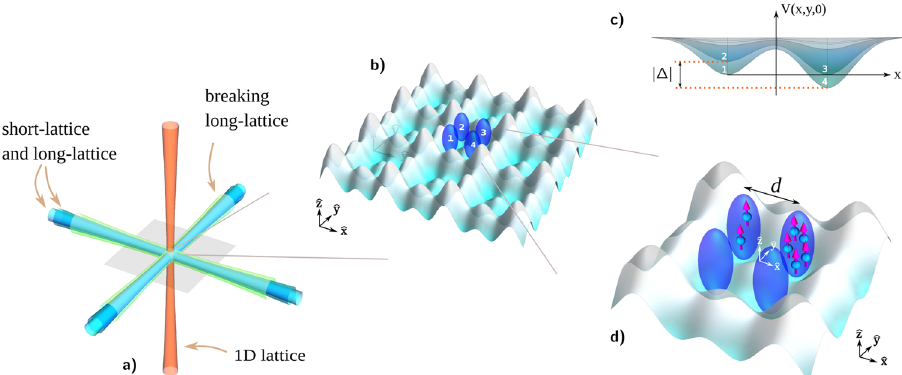
Fig. 4 Trapping scheme of the four-site model. a The 2D square optical lattice is generated with two sets of counter-propagating laser beams crossing at 90° with the other. The superlattice of the four-site model is achieved overlapping the 2D short-lattice (cyan) and long-lattice (blue). The vertical lattice (orange) provides con fi nement in z direction. An additional 2D square long-lattice (green) is used to implement the integrability break control. b Zoom into the region of the superlattice, which contains the four-site plaquette. c Breaking-of-integrability scheme. The system ’ s integrability can be broken by changing the phase difference between the superlattice and the additional 2D square long-lattice, effectively causing a potential imbalance ∣ Δ ∣ between wells 1 and 3 or wells 2 and 4, as in the detail. d The light gray background represents the trapping potential in the vicinities of the four-well system. The cigar-shaped of isosurfaces of the ground-state density, at a distance of d between nearest neighbors, are depicted in blue with direction of dipole aligned in the z -direction represented by purple